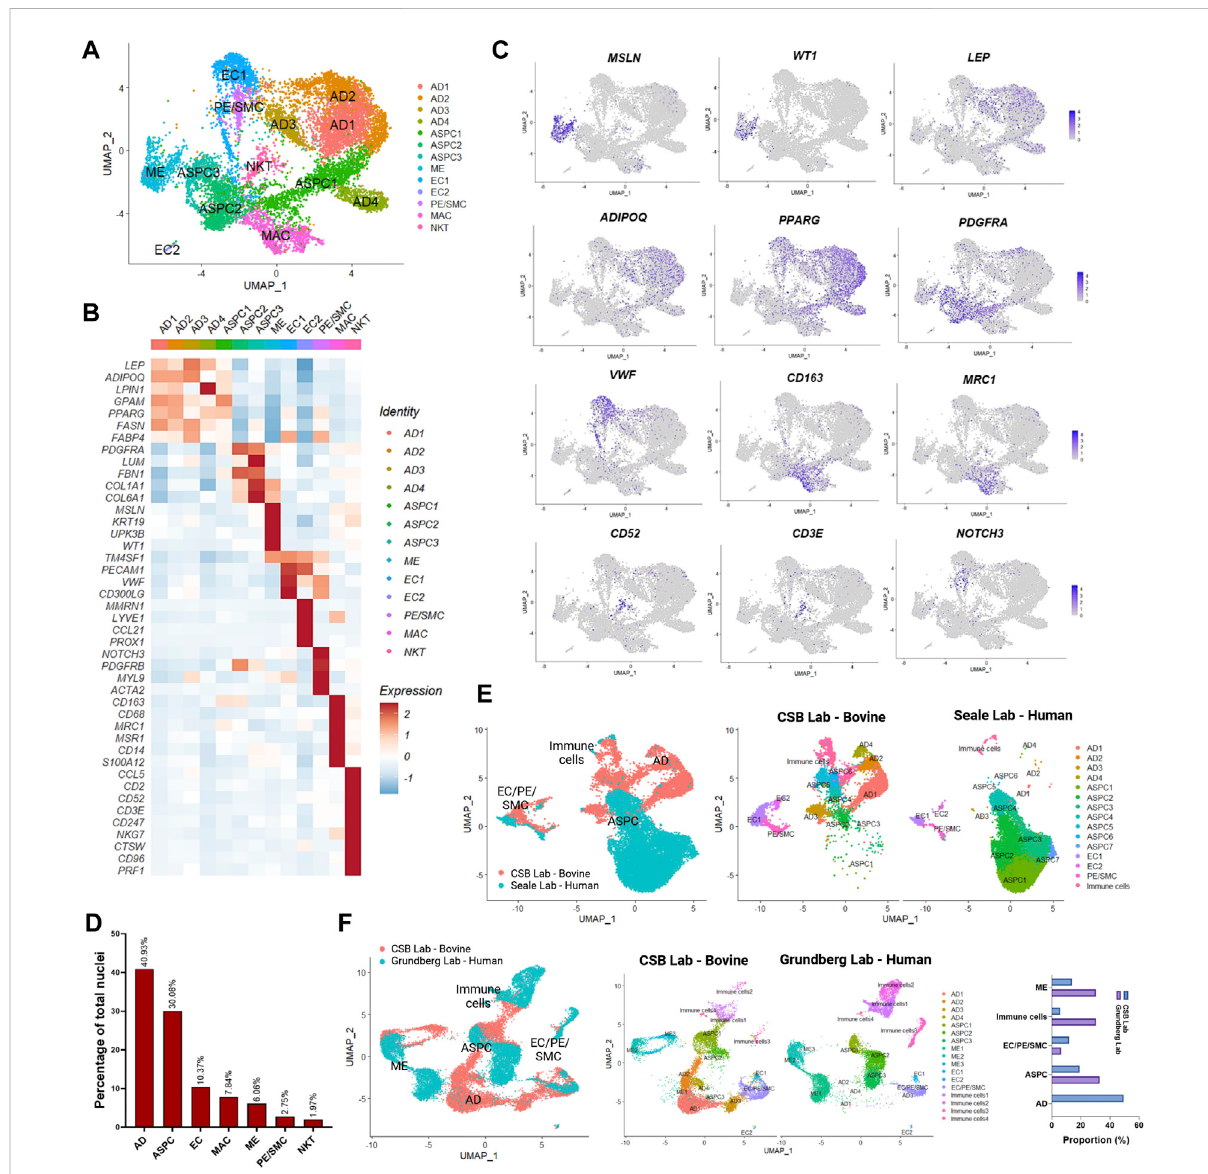
FIGURE 1 Single-nucleiRNAsequencing(snRNA-seq)analysisinsubcutaneous(SAT)andvisceral(VAT)adiposetissuesamplesfromthreedairycows(n= 3). (A) UMAPplotofnucleisubpopulationsincombinedVATandSATsamplesfromdairycows.Cellpopulationswereclassi fi edasmatureadipocytes (AD), adipose steam and progenitor cells (ASPC), endothelial cells (EC), mesothelial cells (ME), pericytes and smooth muscle cells (PC/SMC), macrophages/monocytes (MAC), and natural killer and T-cells (NKT). (B) Heatmap of marker genes expression in cell subtypes identi fi ed by snRNA-seq. Color encodes the scaled average expression level across those cells (dark red: high expression; blue: downregulation). (C) UMAP plots of signature genes for ME ( MSLN and WT1 ), AD ( ADIPOQ and LEP ), ASPC ( PPARG and PDGFRA ), EC ( VWF ), MAC ( CD163 and MRC1 ), NKT ( CD52 and CD3E ),PC/SMC( NOTCH3 ).Purple dotsrepresent individualnucleusexpressing therespective marker. (D) Percentagesofnuclei per